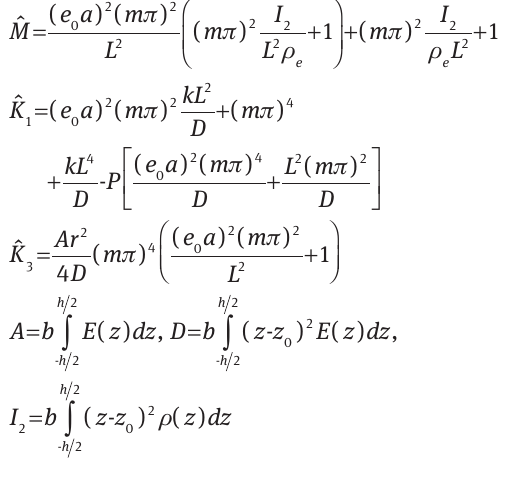
Table 1: Comparison of dimensionless critical buckling load ( P L /